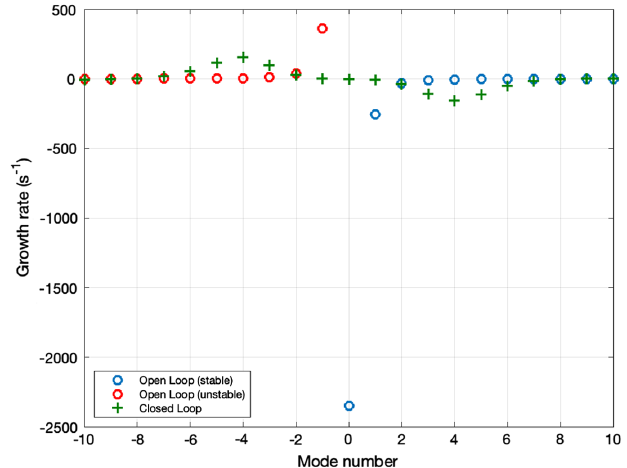
FIG. 21. Growth rate estimates for 200 GeV ion ring.